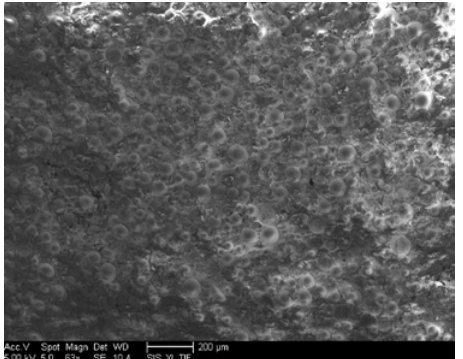
Figure 3 A SEM image of the fracture surface of an IOH sample with a two-step silica particulate size gradation. The PE content is 14 wt%. It can be seen that the silica particulates are well bonded in the PE matrix.